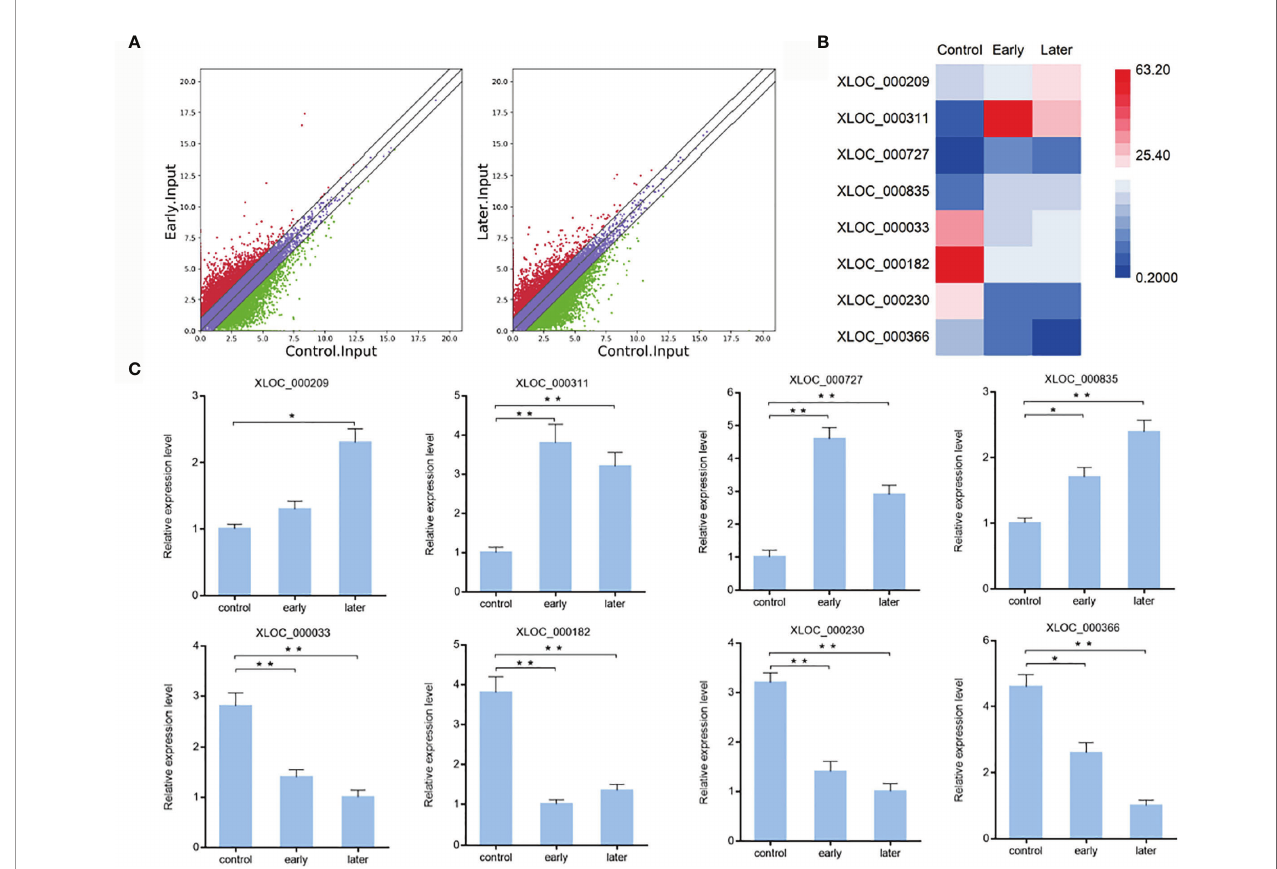
FIGURE 2 | Expression of sea cucumber lncRNAs during Vibrio splendidus infection. (A) Scatter plot of expressed lncRNAs from uninfected (control) sea cucumbers and at day 1 (early) or day 7 (later) after Vibrio splendidus infection of sea cucumbers. X-axis and Y-axis present log2 value of FPKM of different samples, respectively. (B) Heat map analysis of selected differentially expressed lncRNAs based on the high-throughput sequencing data, red and blue represent upregulated and downregulated lncRNAs, respectively. (C) Expression of selected lncRNAs in sea cucumber. At different time post-infection, total RNAs were extracted from the coelomocytes of sea cucumbers, the expression level of lncRNAs were detected using quantitative real-time PCR. The error bars denote the means ± SD of three independent experiments (* p < 0.05; ** p < 0.01). b -actin was used as a